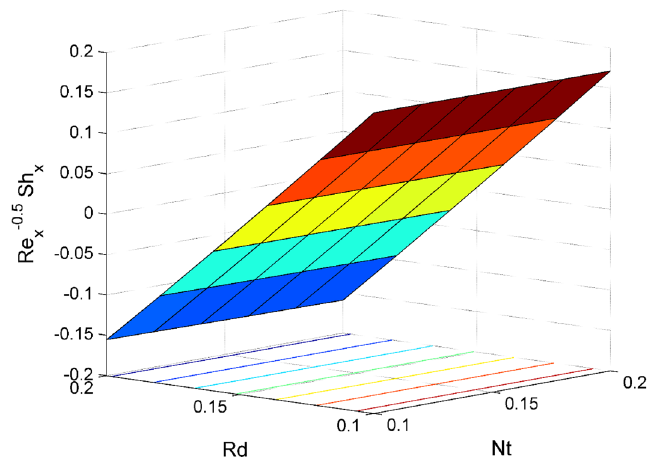
Figure 21. Effect of Rd and Nt on Re − 0.5 y Sh x .